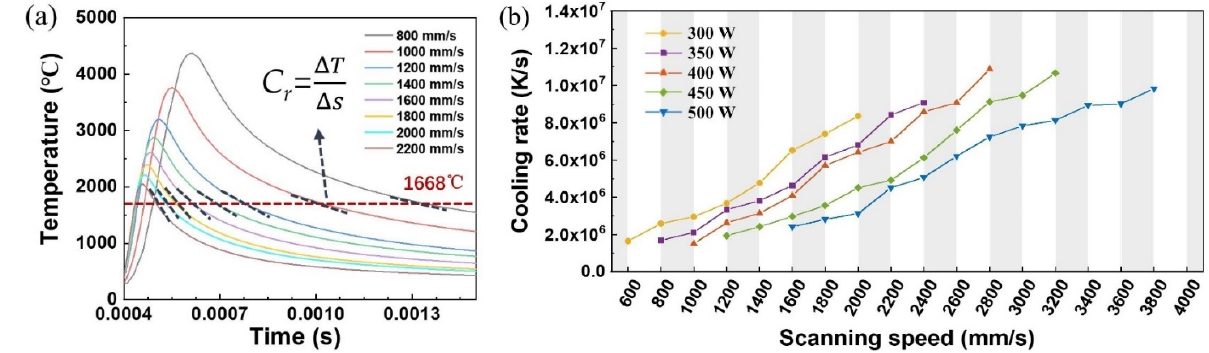
Figure 9. ( a ) Illustration of the extraction of solidification cooling rates from temperature–time curves; ( b ) Effect of different process parameters on cooling rate.